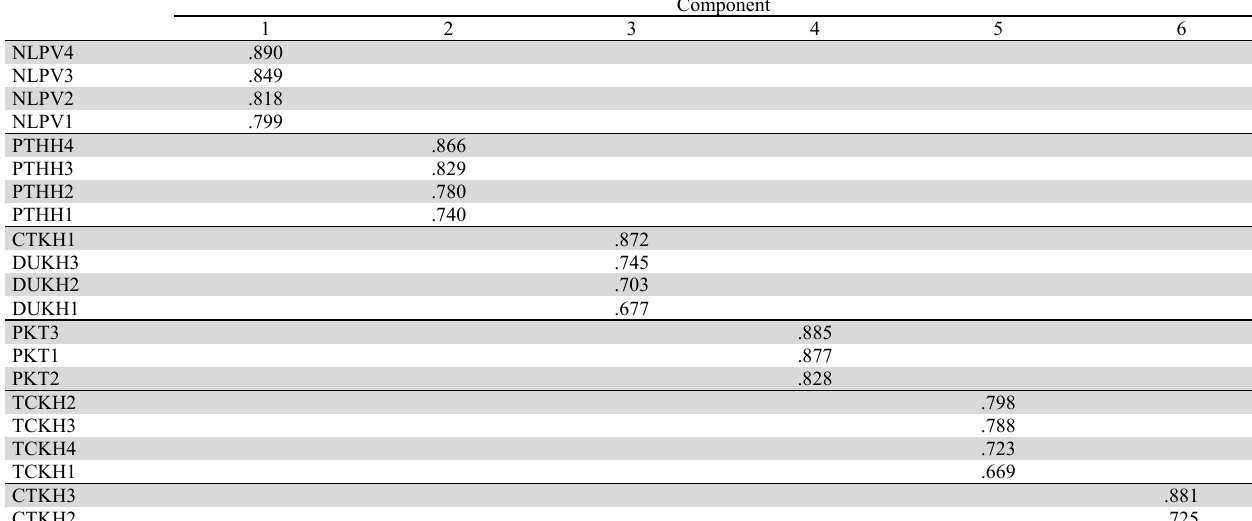
Rotated Component Matrix a (2